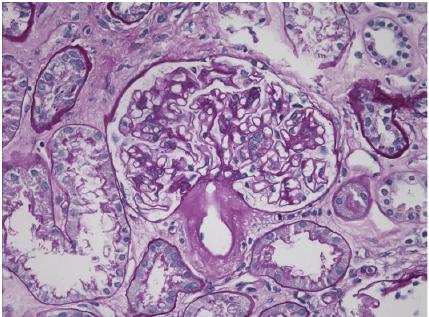
Figure 1: Light microscopy. Adjacent e ff erent arteriole with signifi- cant deposits of amorphous eosinophilic material; glomerulus with same limited and segmental deposits in its wall; interstitium with the same